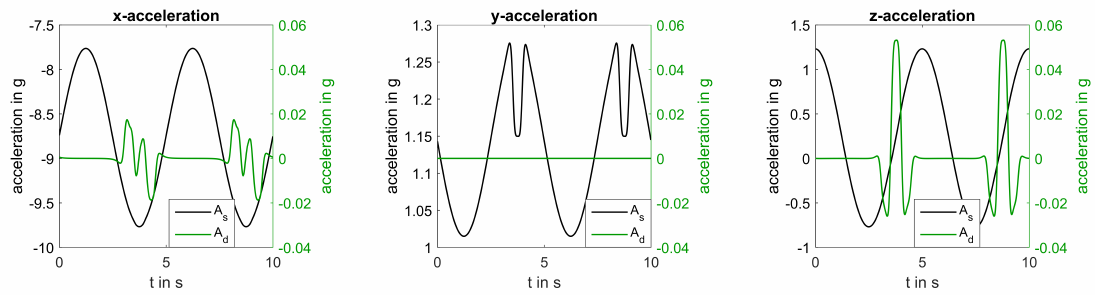
Figure 5. Comparison of static acceleration and overall acceleration of all three axes simulated for β = γ = 0° and R =